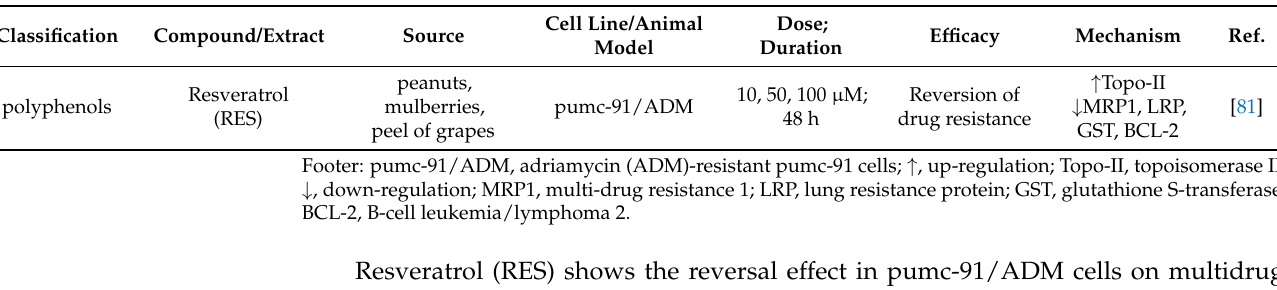
Table 6. Natural Products sensitizing Drug Resistance.